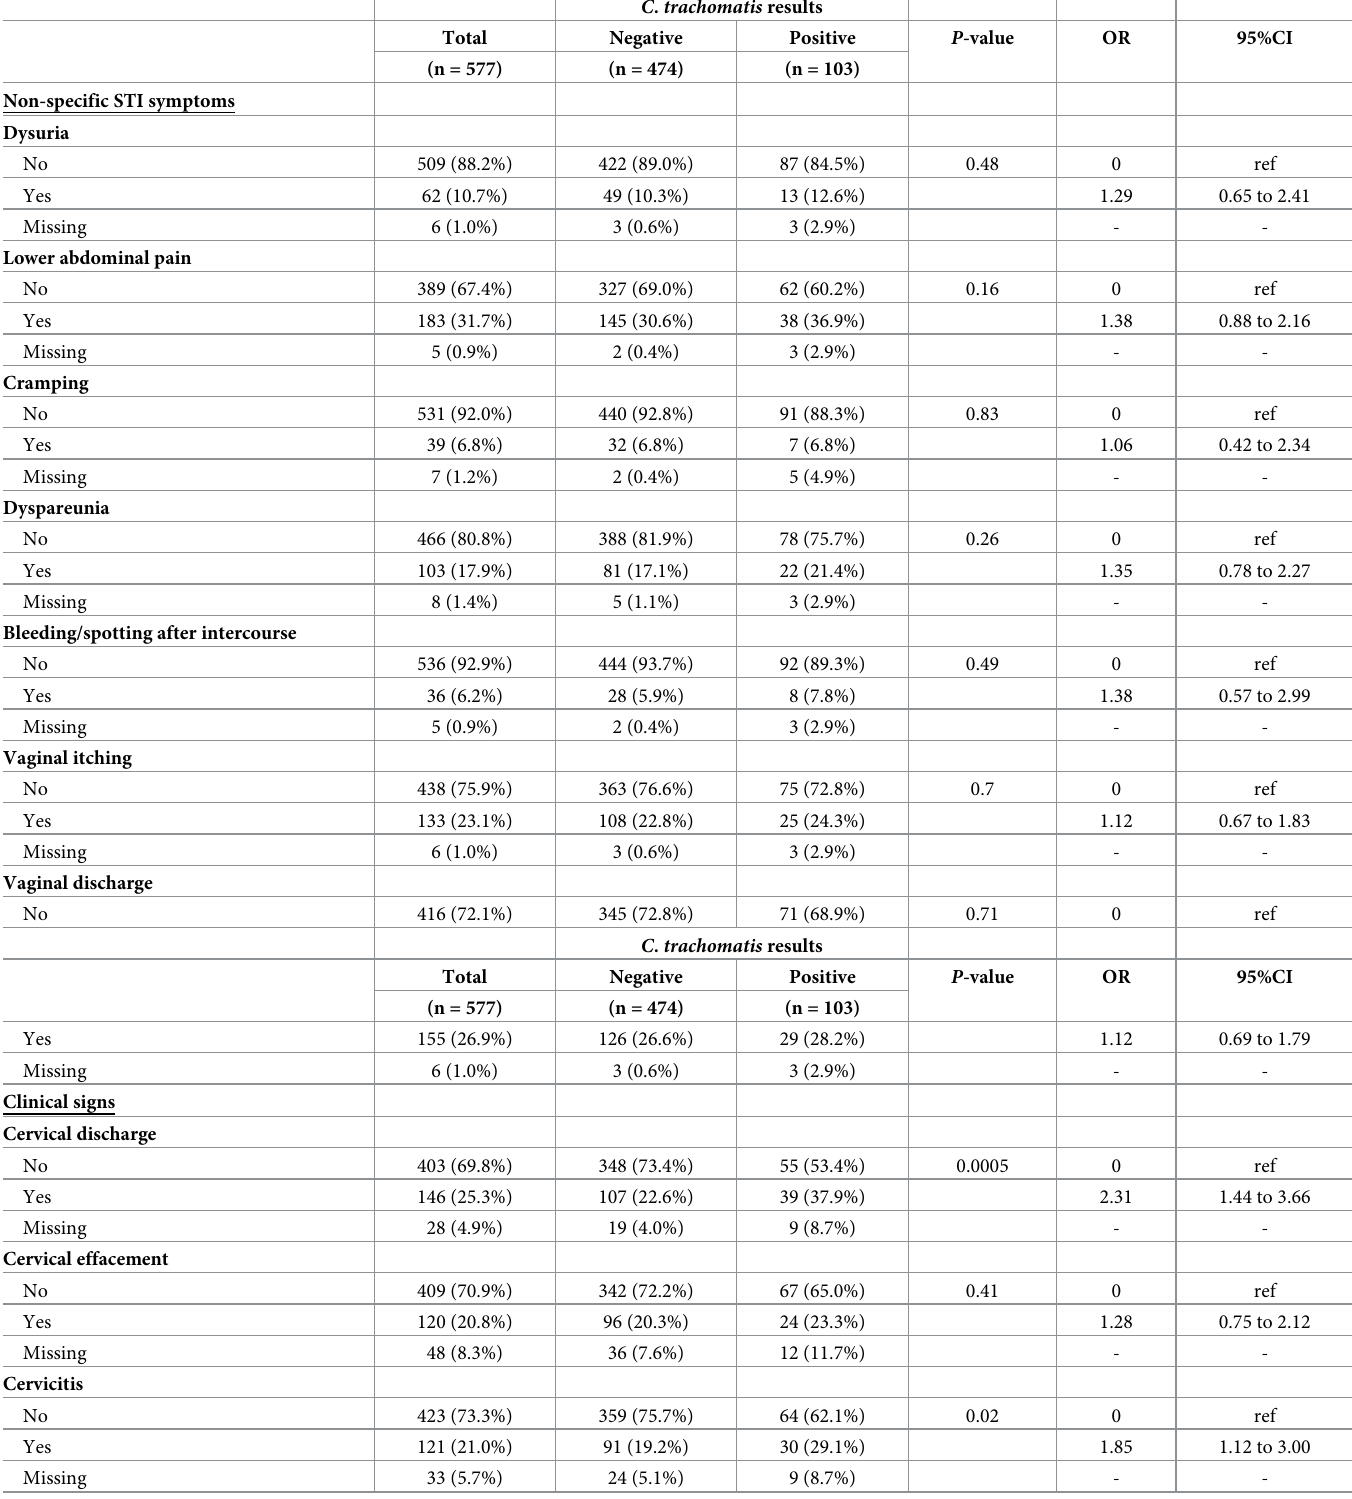
Table 3. Non-specific symptoms and clinical signs associated with C . trachomatis